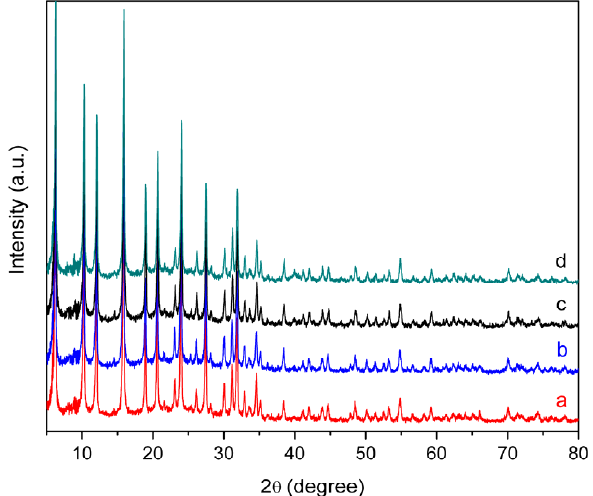
Figure 5. XRD patterns for H-Y zeolite ( a ), 0.5Pd@Y ( b ), 1Pd@Y ( c ), and 1.5Pd@Y ( d ) samples.